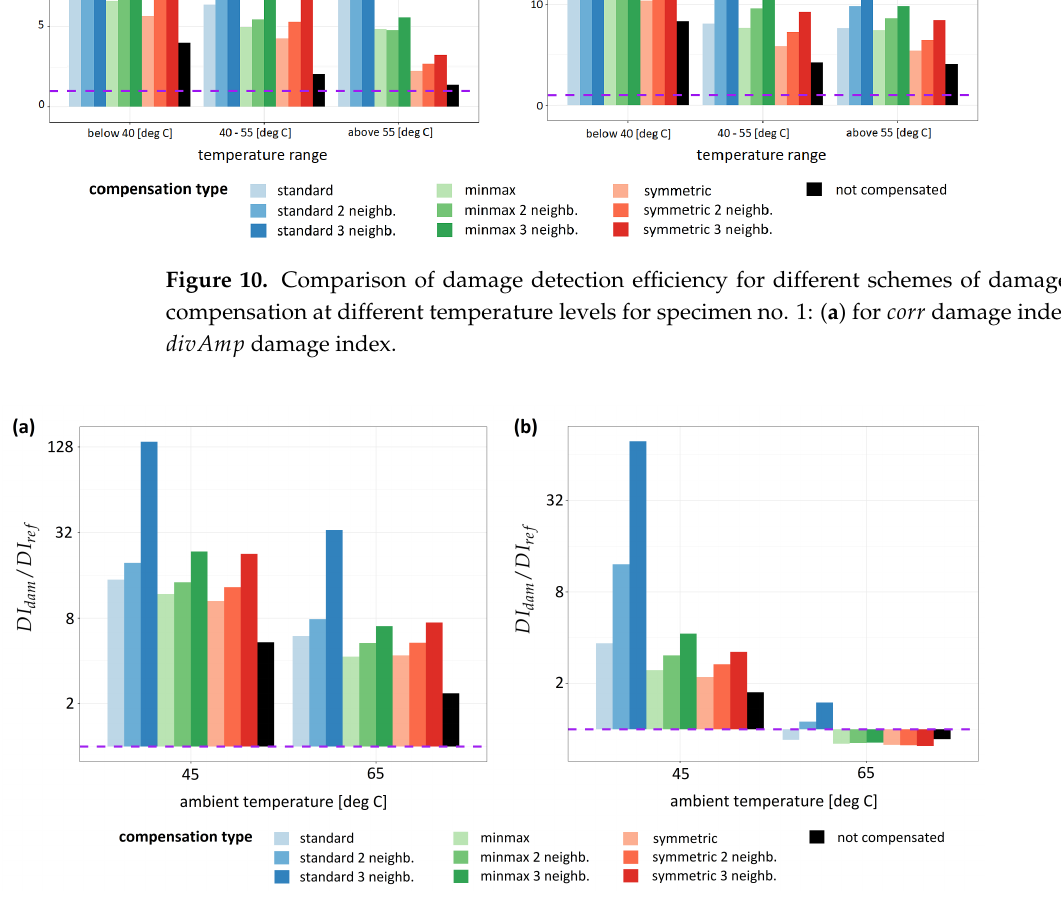
Figure 11. Comparison of damage detection efficiency of different schemes of damage indices compensation at different temperature levels for specimen no. 2: ( a ) for corr damage index; ( b ) for divAmp damage index. Table 1. D ef f coefficient for corr damage index obtained for specimen no.